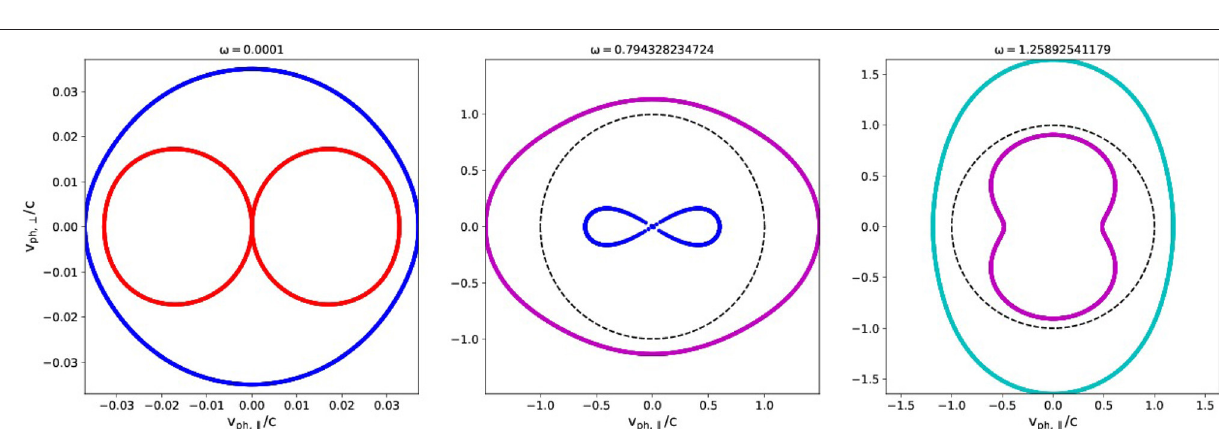
FIGURE 7 | Dispersion diagram for a hydrogen ion-electron plasma at E the E 1.5 hydrogen plasma at near-parallel ϑ = frequencies for which Figure 8 shows wave normal surfaces.